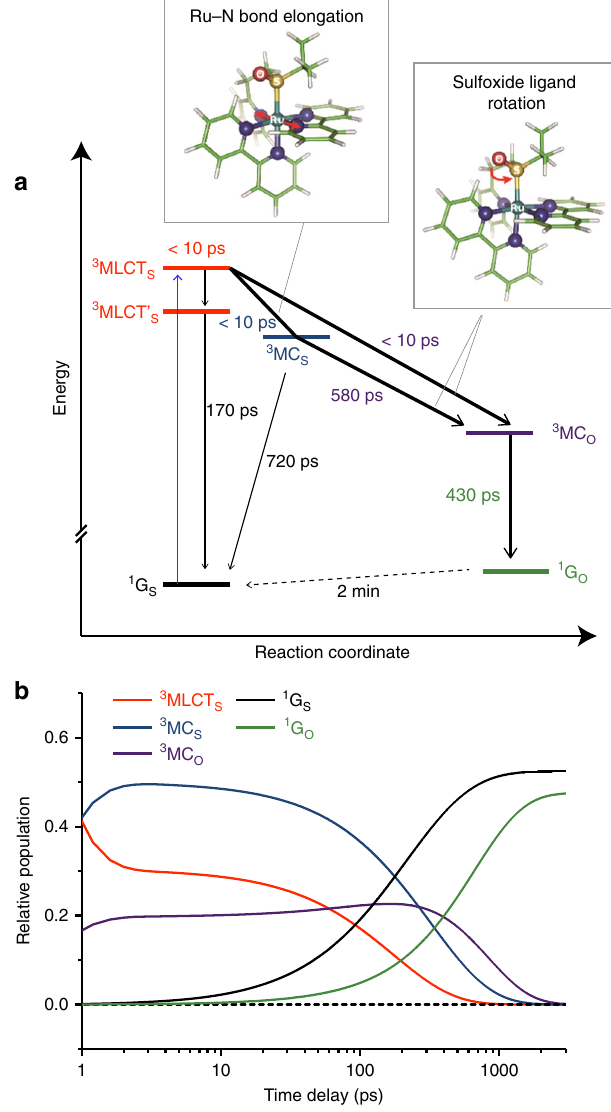
Fig. 5 Proposed mechanism and kinetics for the photoisomerization of [Ru (bpy) 2 (pyESO)] 2 + . a Proposed photoisomerization mechanism with labels indicating electronic state and lifetime for each ground state and intermediate structure. Bold arrows indicate the basic mechanistic requirements required to describe the Ru and S edge data, including the necessity of MC excited states (Ru edge) and of two isomerization pathways (S edge), and the formation time for the O-bonded ground state. Insets show the major structural changes that accompany electronic transitions. b Time-dependent fractional population for each